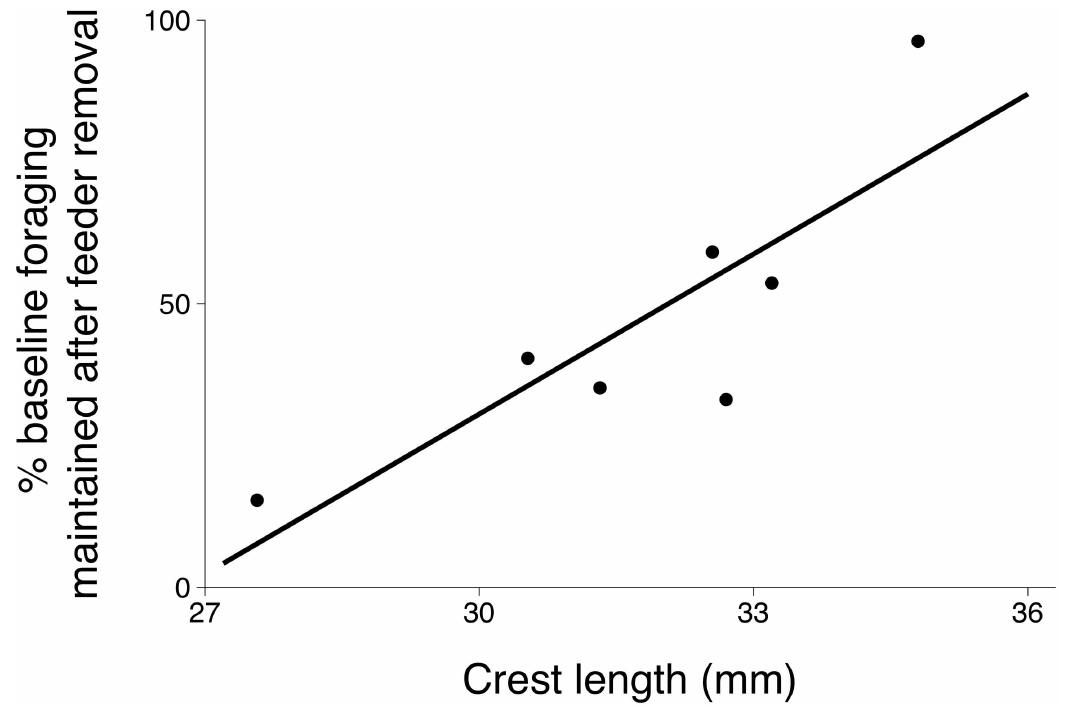
Fig 3. After experimental reduction in the number of supplemental feeders, the relationship between crest length and an individual’s success at maintaining its own baseline level of accessto feeders.